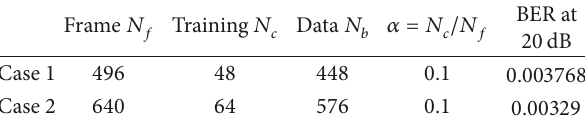
Table 2: Various system parameters for different choices. Frame 푁 푓 Training 푁 푐 Data 푁 푏 훼 = 푁 푐 /푁 푓